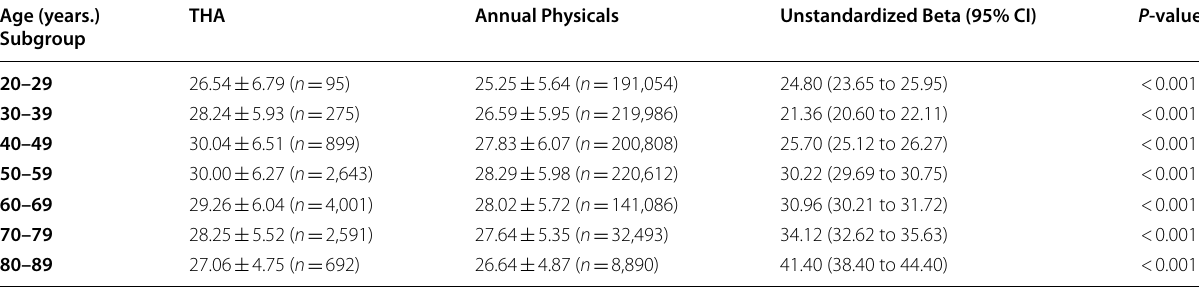
Table 5 BMI Comparison in Matched Age Subgroups (2013–2020) Age (years.)